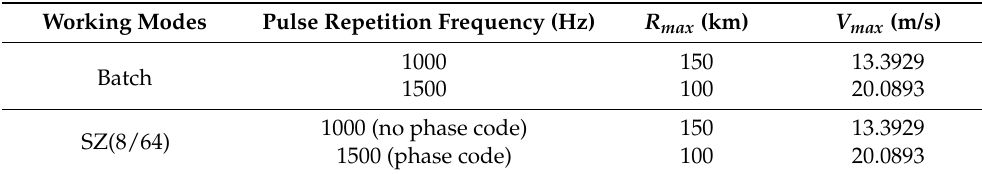
Table 3. Radar working parameters used in simulation.